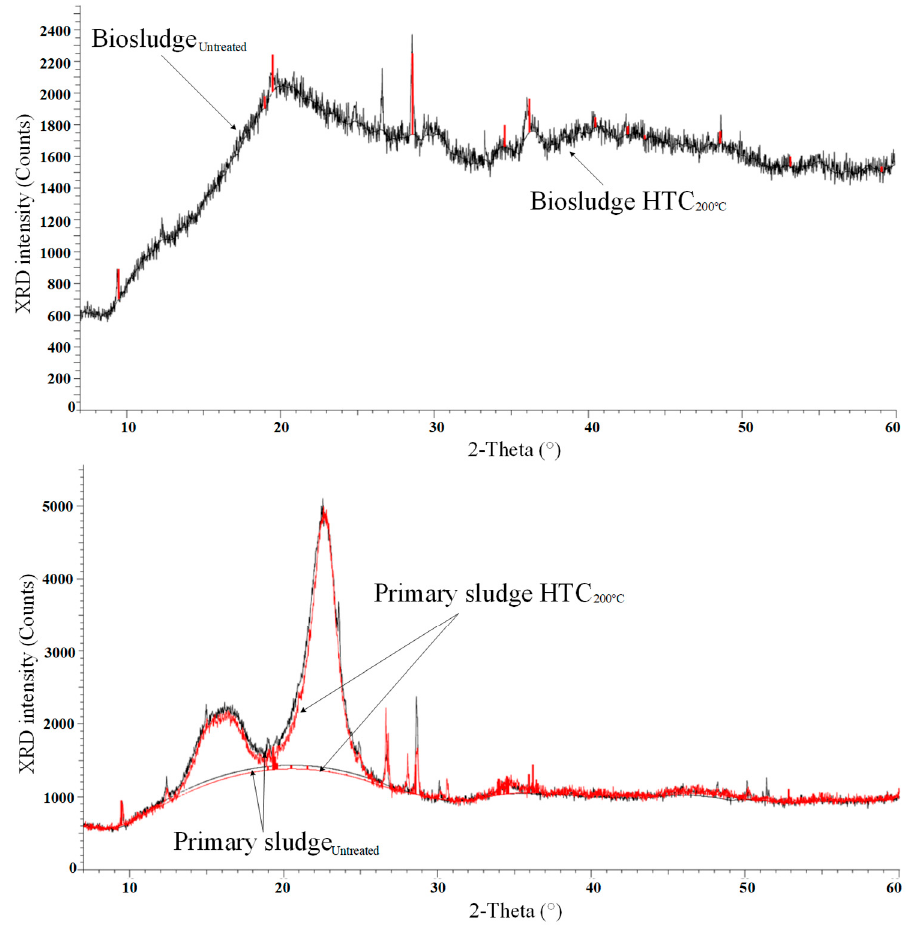
Figure 8. XRD spectra of PS and BS samples.